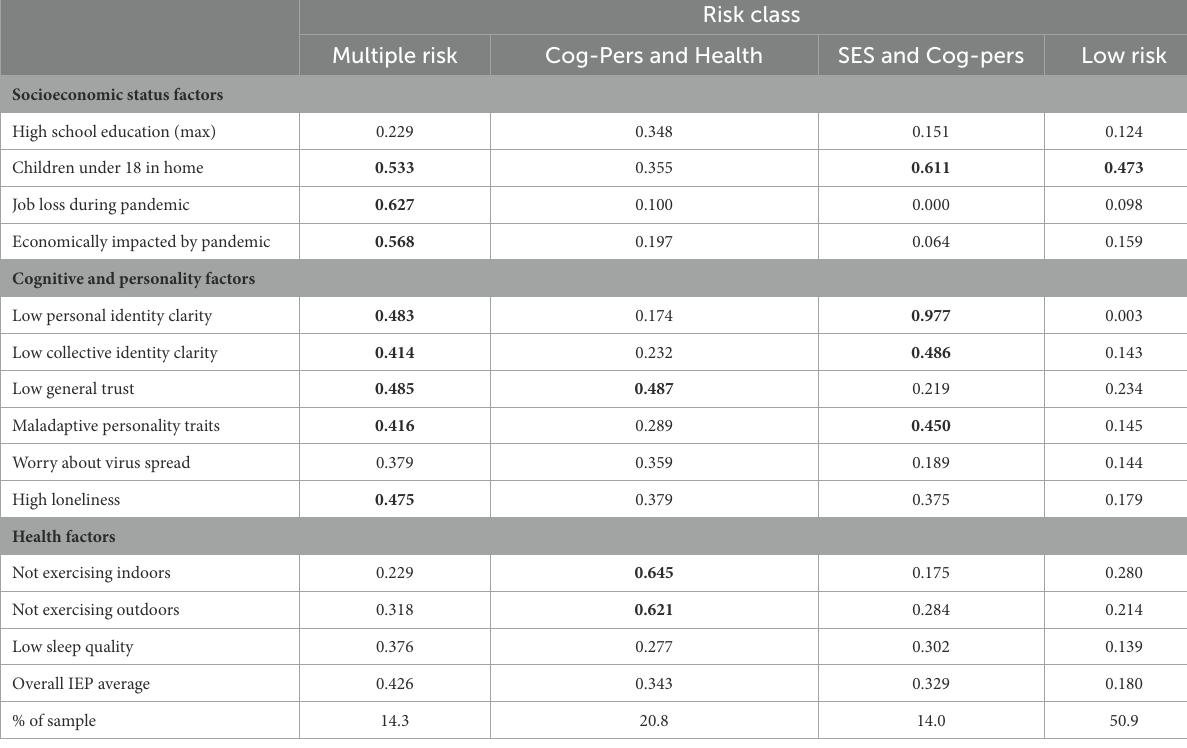
TABLE 3 Item endorsement probabilities for each risk indicator by risk